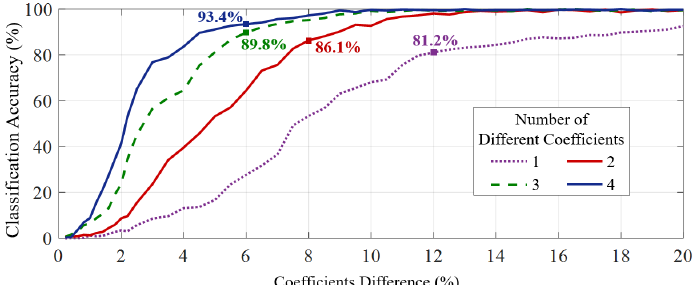
Figure 9. User classification accuracy under different degrees of feature differences.